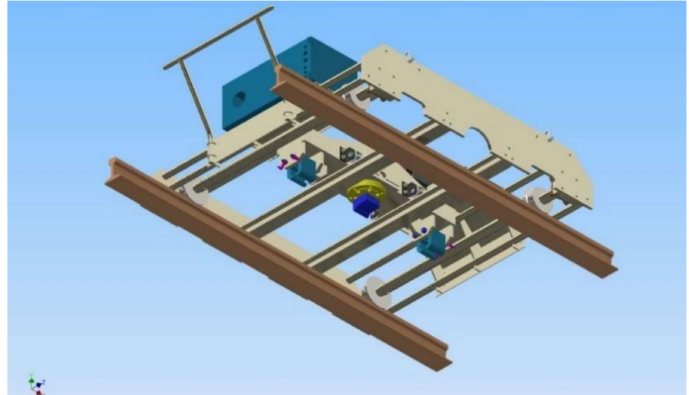
Figure 13. Modeling of the TSS tester.